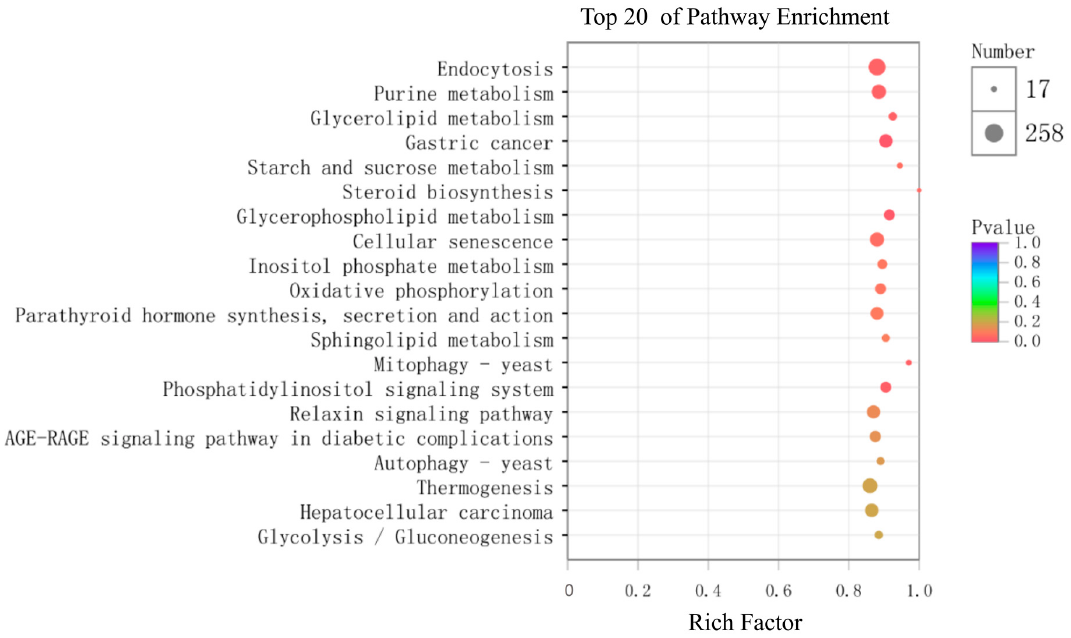
Figure 7. Bubble plot showing the 20 most enriched KEGG (Kyoto Encyclopedia of Genes and Genomes) pathways. The x-axis shows the rich factor, while the y-axis indicates the KEGG pathway terms.